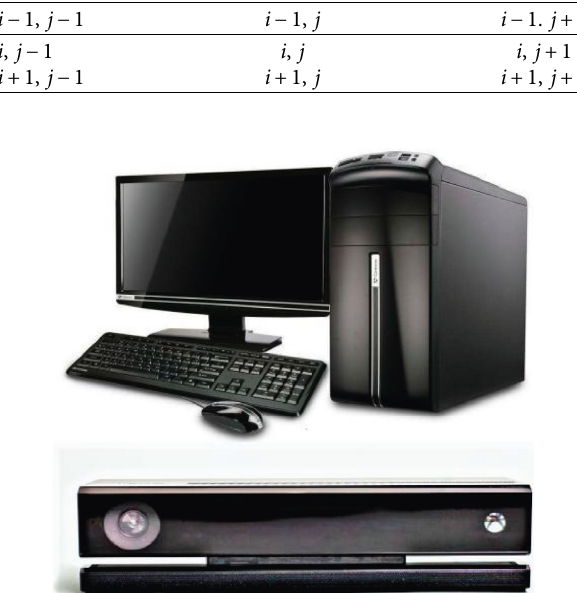
Figure 5: Kinect somatosensory device and